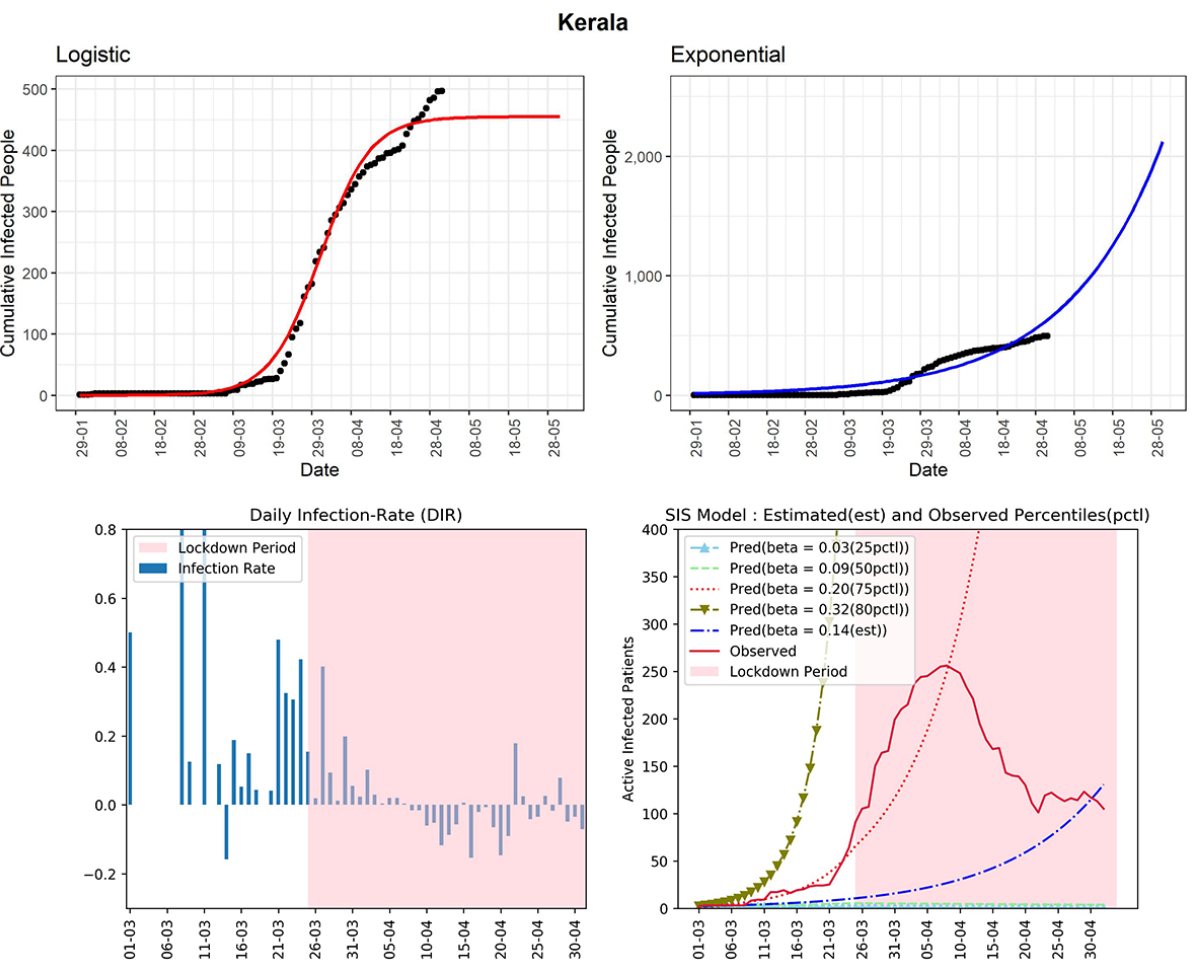
Figure 13. Graphs for the state of Kerala. SIS: